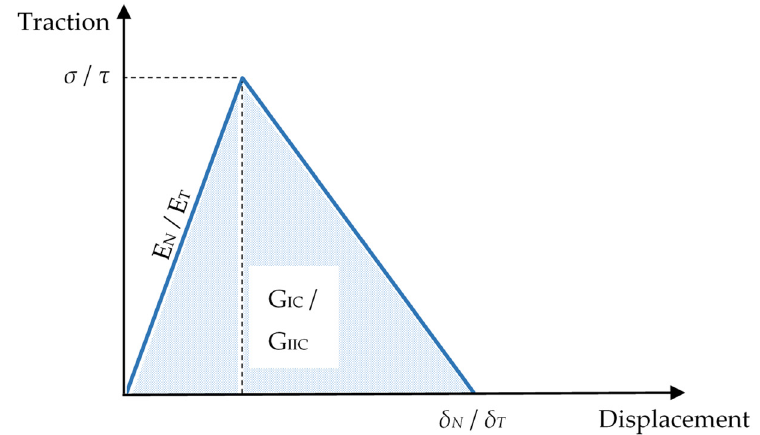
Figure 1. Bilinear traction separation law.